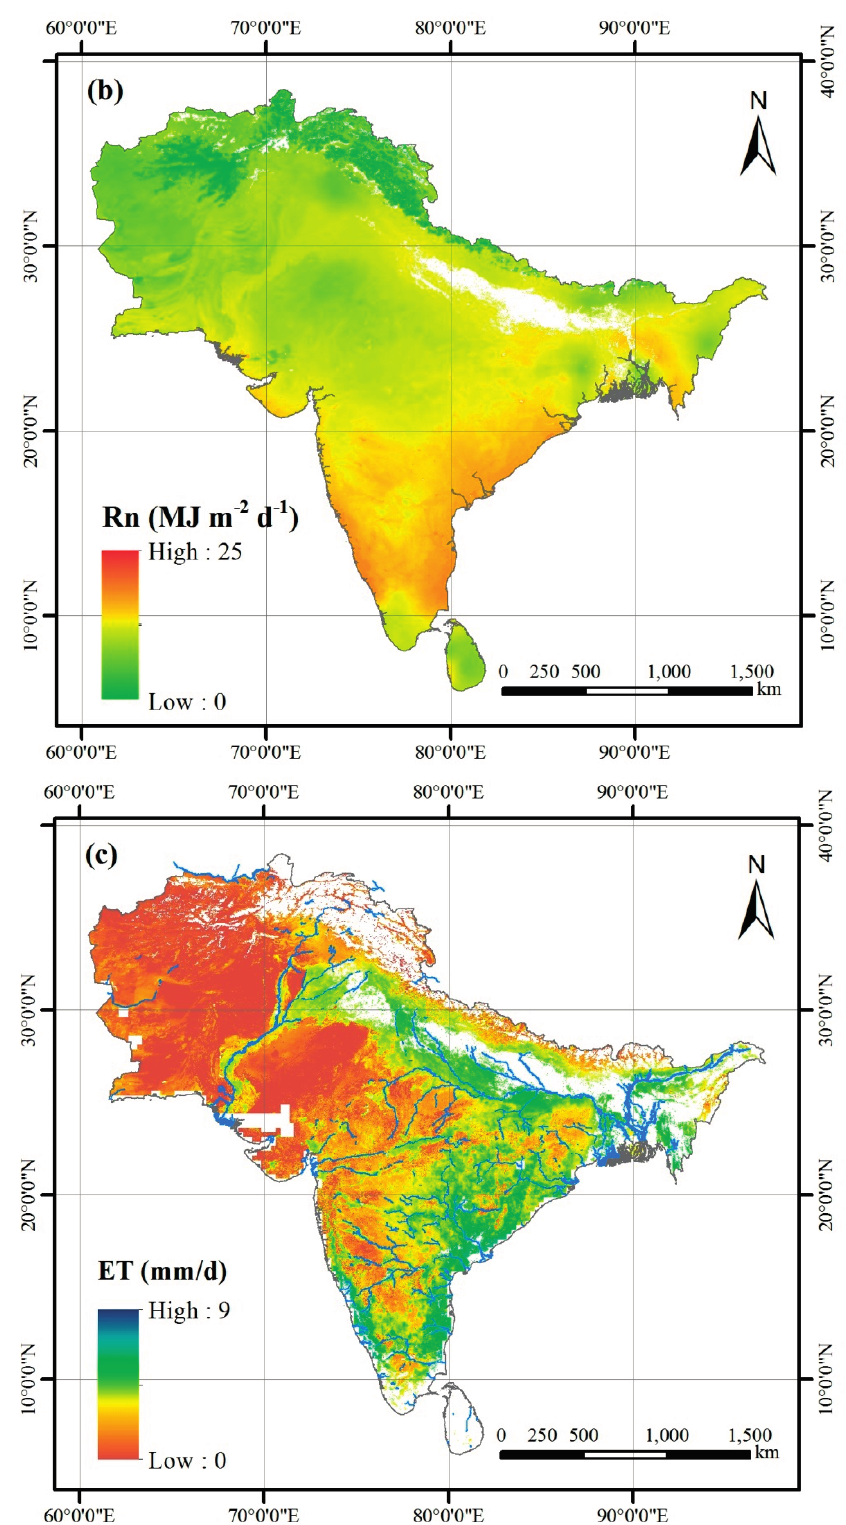
Figure 3. ( a ) Evaporative Fraction (EF); ( b ) Daily net radiation and ( c ) Daily ET estimation results of South Asia on 2 March